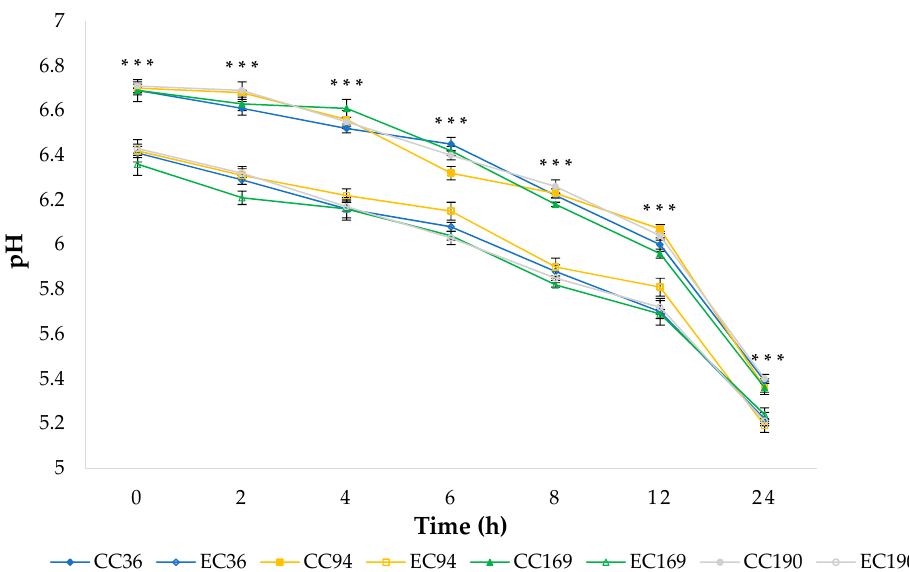
Figure 1. Acidification kinetics of curds. Full symbols: Control curds. Empty symbols: Experimental curds. Results indicate mean values ± SD of four determinations (carried out in duplicate for two independent productions). In comparison with the corresponding result of grape pomace powder (GPP)-enriched curd, values are significant with *** p < 0.0001. Abbreviations: CC36, CC94, CC169, and CC190, control curd with L. lactis MISE36, MISE94, MISE169, and MISE190, respectively; EC36, EC94, EC169, and EC190, experimental curd with 1% of GPP and L. lactis MISE36, MISE94, MISE169, and MISE190, respectively. Bars represent standard deviation of the mean. The lower values of pH in experimental curds are imputable to the presence of or ‐ ganic acids such as tartaric acid, malic acid, and citric acid in GPP [7]. However, all curds reached the value comprised in the range 5.20–5.40, which represents the optimum level of acidity allowing the stretching of the curd [33], about 24 h after curdling (Figure 2).